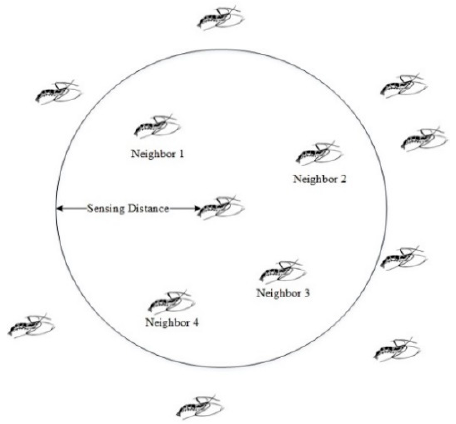
Figure 13. Sensing ambit around an individual krill.